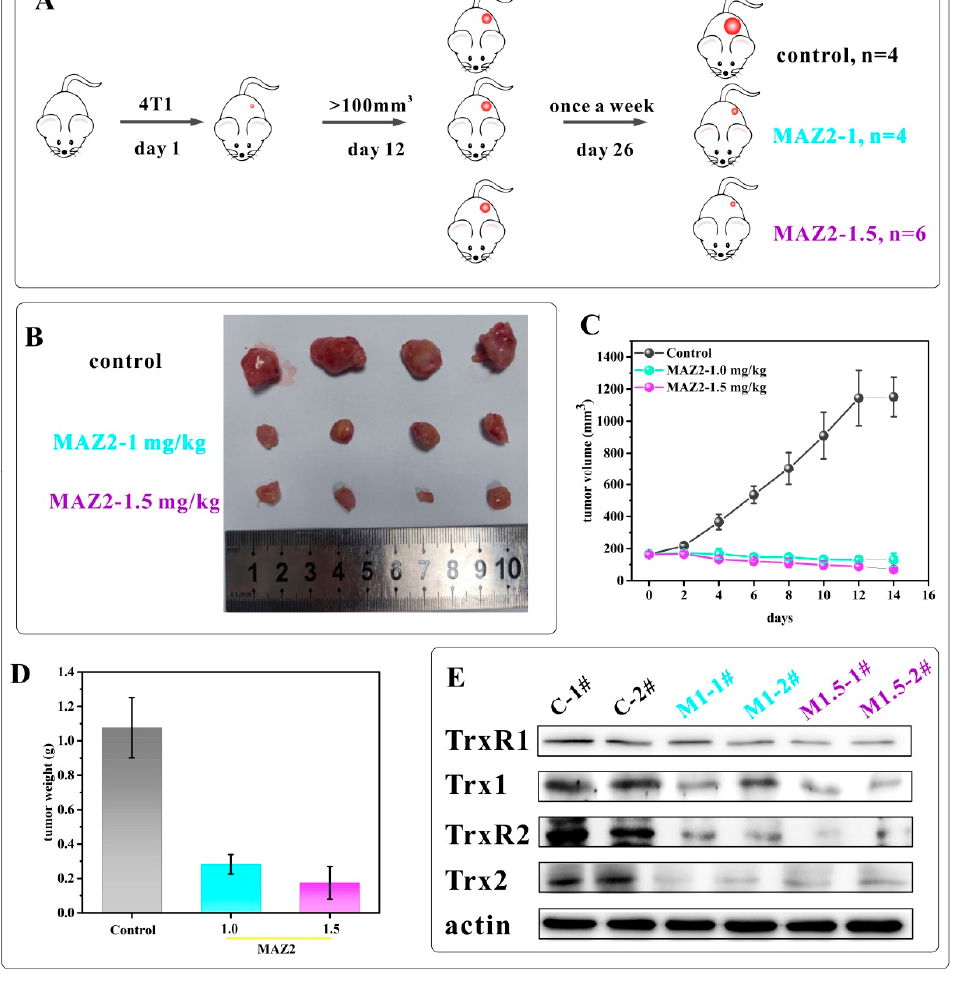
Figure 4. The 4T1 tumors were eliminated by two administrations of MAZ2; ( A ) is a scheme of the mice experiments; ( B ) is a tumor picture after mice sacrifice; ( C ) is the tumor volume; ( D ) is the tumor weight; and ( E ) is the Trx system protein content determined by WB. The tumors in the vehicle (control) group grew rapidly, while an injection of 1 mg/kg or 1.5 mg/kg of MAZ2 once a week could completely reverse the growth of tumors and gradually eliminate tumors (Figure 4C). The average tumor weight of the MAZ2 administration groups was reduced by 30% and 15%, respectively (Figure 4D), support- ing the high anti-tumor activity of MAZ2. To prove the target of MAZ2 in vivo, the TrxR and Trx content was determined by western blot (Figure 4E). As shown in Figure 4E, two tumors in each of the groups were dissolved and the TrxR and Trx content from each tumor of every group demonstrated almost no difference, implying credible results. MAZ2 reduced the TrxR1 content slightly and reduced the Trx1 content by a large amount. The mitochondrial forms of the Trx system proteins were almost eliminated by MAZ2 administration.